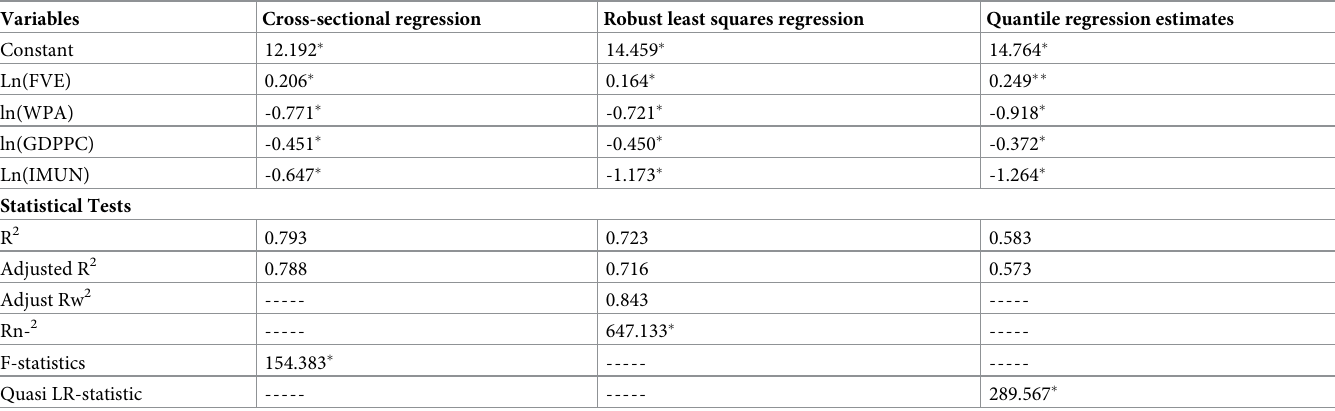
Table 4. Regression